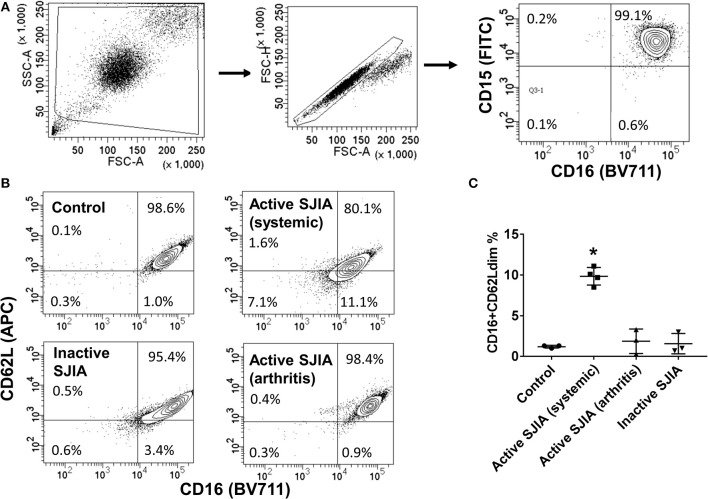
Flow cytometry analysis of highly purified neutrophil populations. Neutrophils were stained with FITC-conjugated anti-CD15, BV711-conjugated anti-CD16, and APC-conjugated anti-CD62L before being analyzed. (A) Cells were gated for live cells by FSC/SSC, then for doublet discrimination, then to identify percentage of CD15+CD16+ neutrophils. (B,C) Neutrophils were analyzed for relative percentage of mature CD16+CD62Ldim cells. Gates were set using healthy controls to define CD62L thresholds. Data are representative of control neutrophils, neutrophils from patients with SJIA and active systemic features, active arthritis only, and inactive SJIA. Pooled data are shown in (C). *p = 0.001 vs. control as determined by ANOVA with Dunnett's multiple comparisons test.